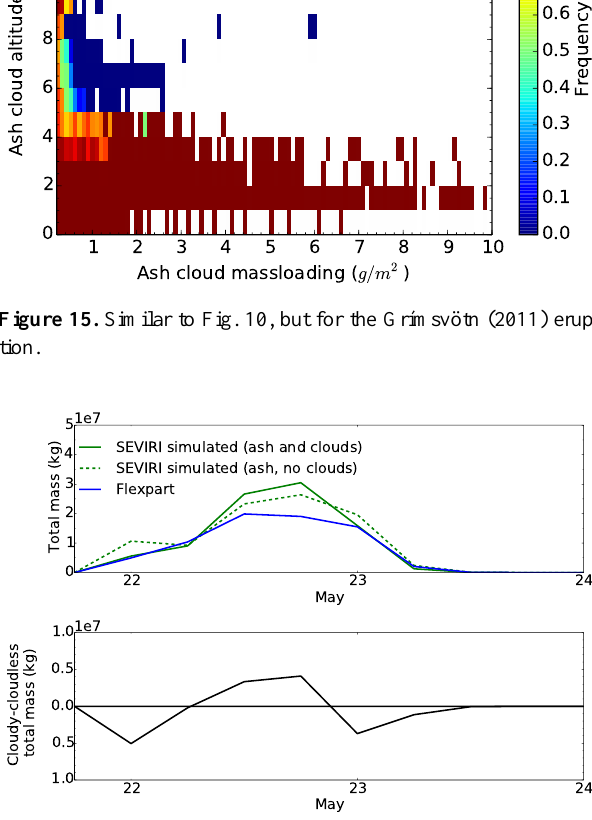
Figure 16. Similar to Fig. 11, but for the Grímsvötn (2011) erup-